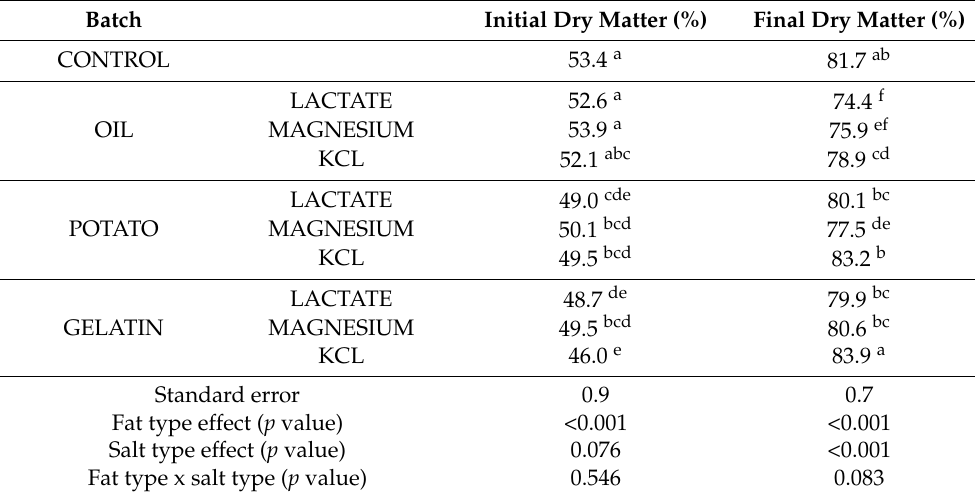
Table 1. The means and standard error for the dry matter (%) of 10 experimental batches of dry- fermented sausages and the p values for studied effects (fat type and salt